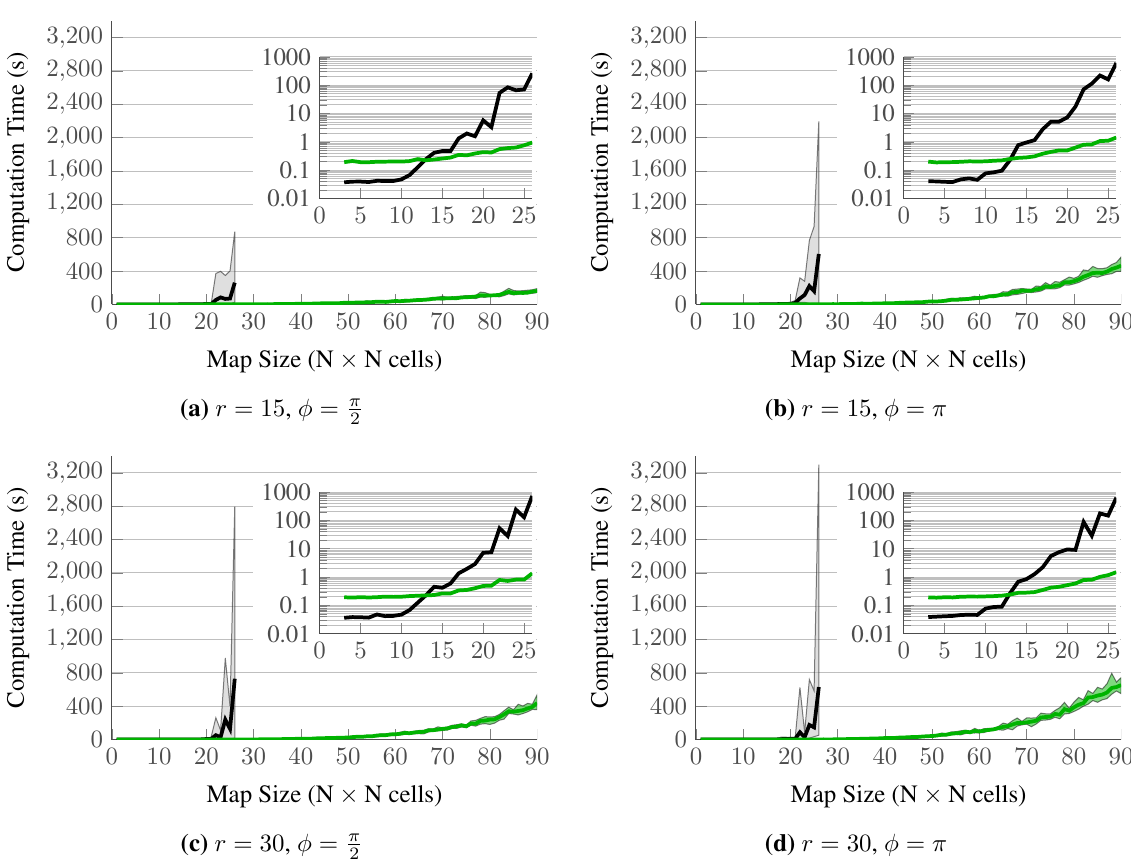
Figure 13. Computation times to calculate the optimal solutions and to solve the instances with conv -SPP. The thick lines represent the average computation times for each set of maps, while the colored intervals are bounded by the minimum and maximum times it took to solve all the instances in one set. The inset graphs show the computation times on a logarithmic